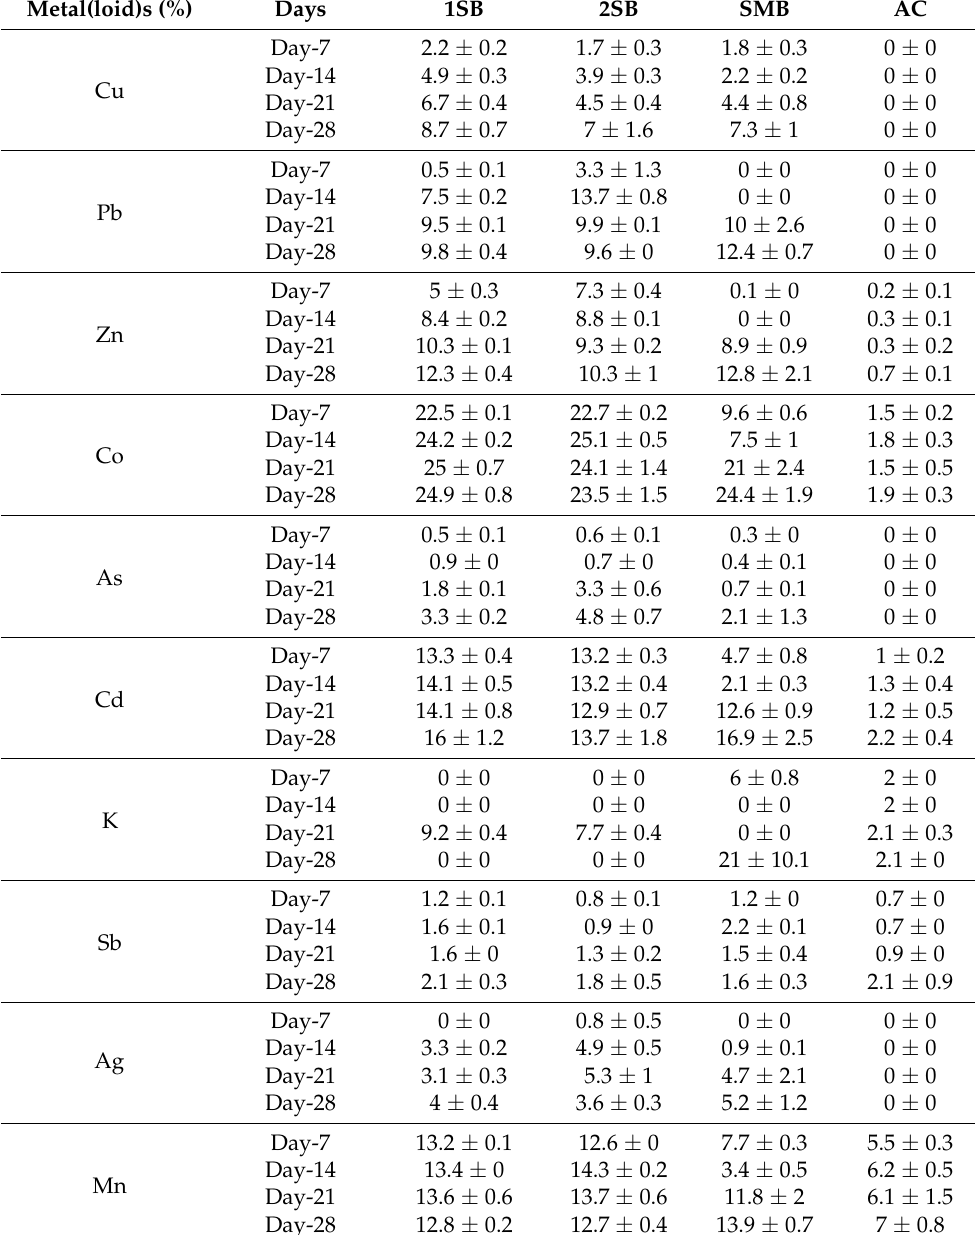
Table A3. Percentages of the metal(loid)s extracted from the Neves Corvo waste rock by T. electrotropha via one-step bioleaching (1SB), two-step bioleaching (2SB), spent medium bioleaching (SMB), and the abiotic control (AC). Values are the average of duplicate flasks ± standard